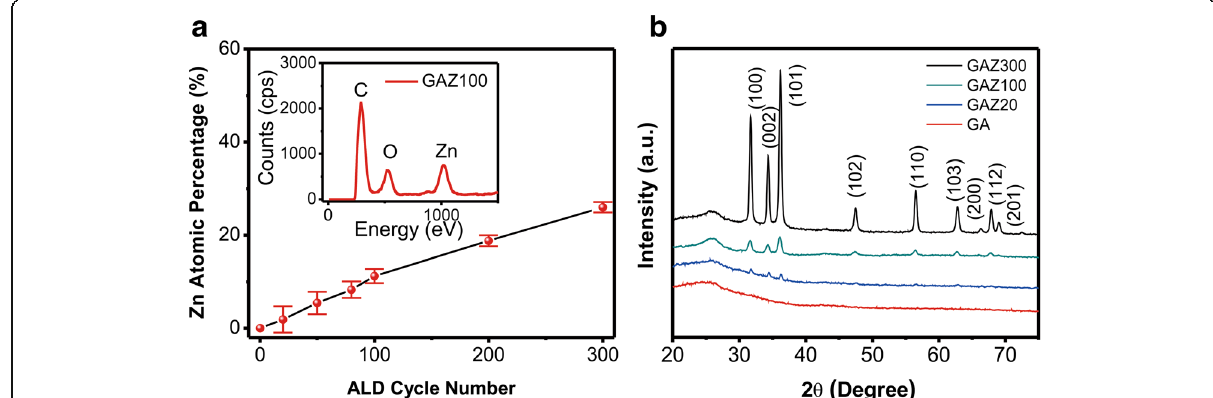
Fig. 2 a Atomic percentage of Zn atoms in GAZ composite. The inset is the EDS result of GAZ100. b XRD patterns of GA and GAZ composites with different ALD cycles